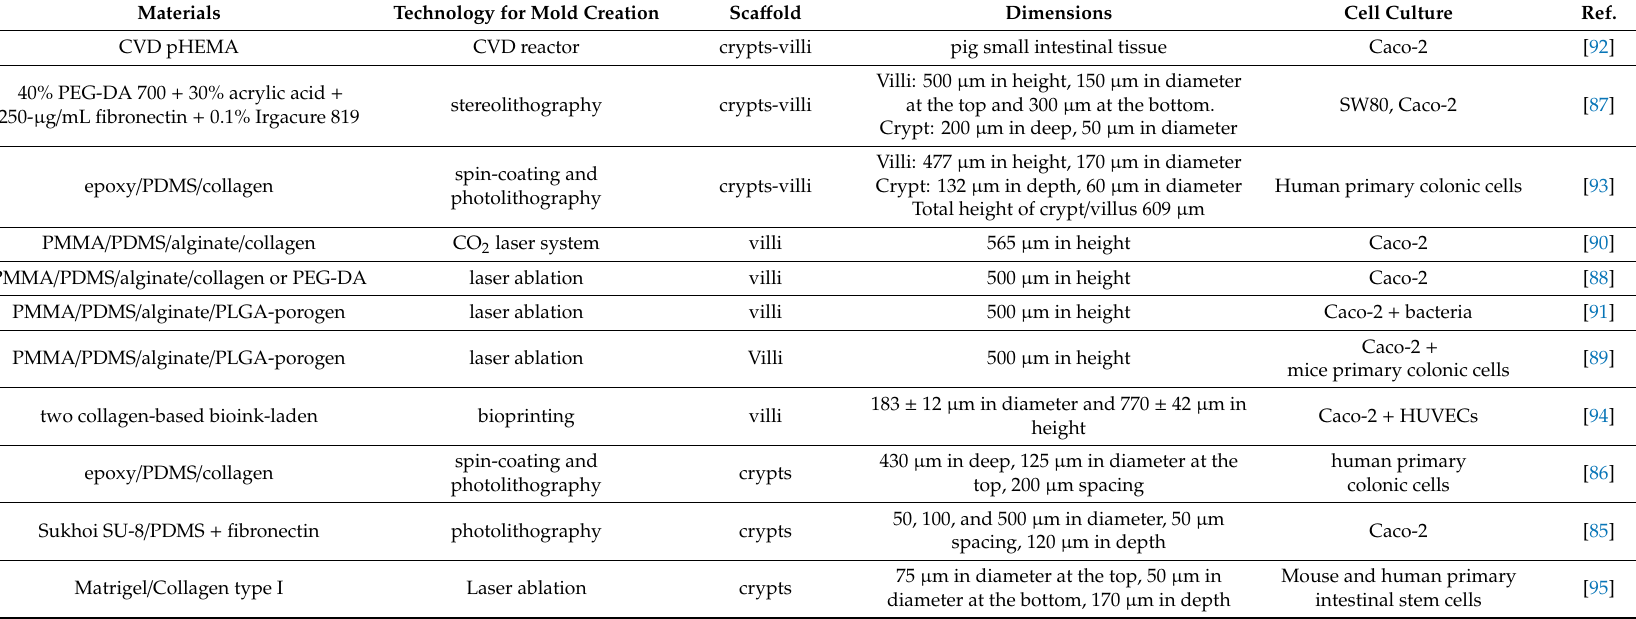
Table 2. Summary of the fabrication processes for intestinal 3D sca ff olds. CVD: chemical vapor deposition and pHEMA: poly(2-hydroxyethylmethacrylate). PED-GA: poly(ethylene) glycol diacrylate, PDMS: polydimethylsiloxane, PMMA: polymethyl methacrylate, PLGA: poly-lactic-glycolic acid and HUVEC: human umbilical vein endothelial